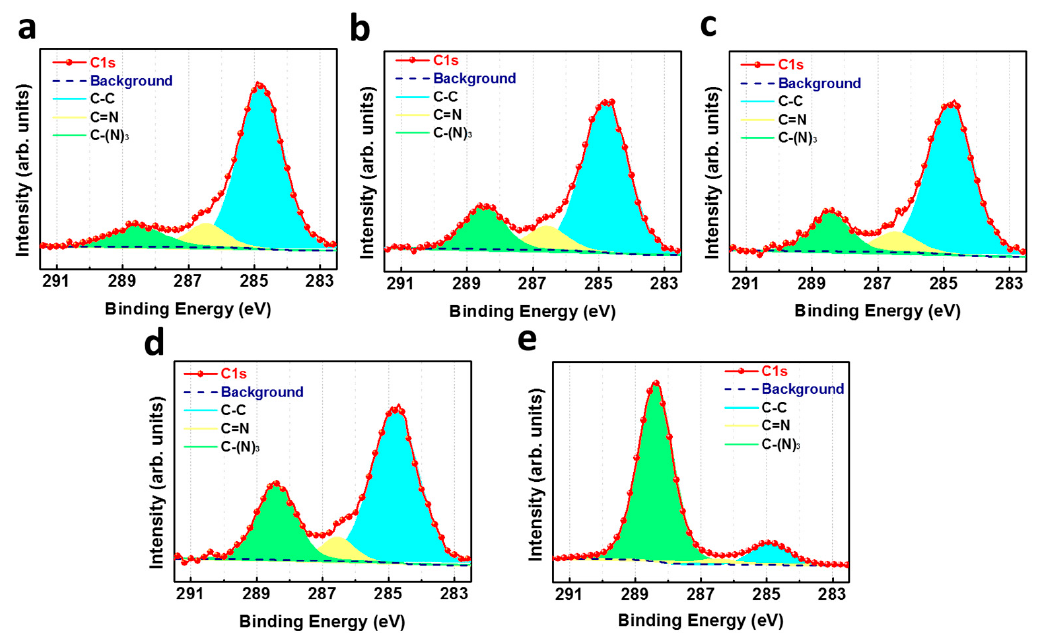
Figure 5. XPS spectra for C 1s orbital of g-C 3 N 4 /TiO 2 catalyst with various g-C 3 N 4 addition, ( a ) 1.0 wt% ( b ) 3.0 wt%, ( c ) 5.0 wt%, and ( d ) 10.0 wt%, and ( e ) pristine g-C 3 N 4 .